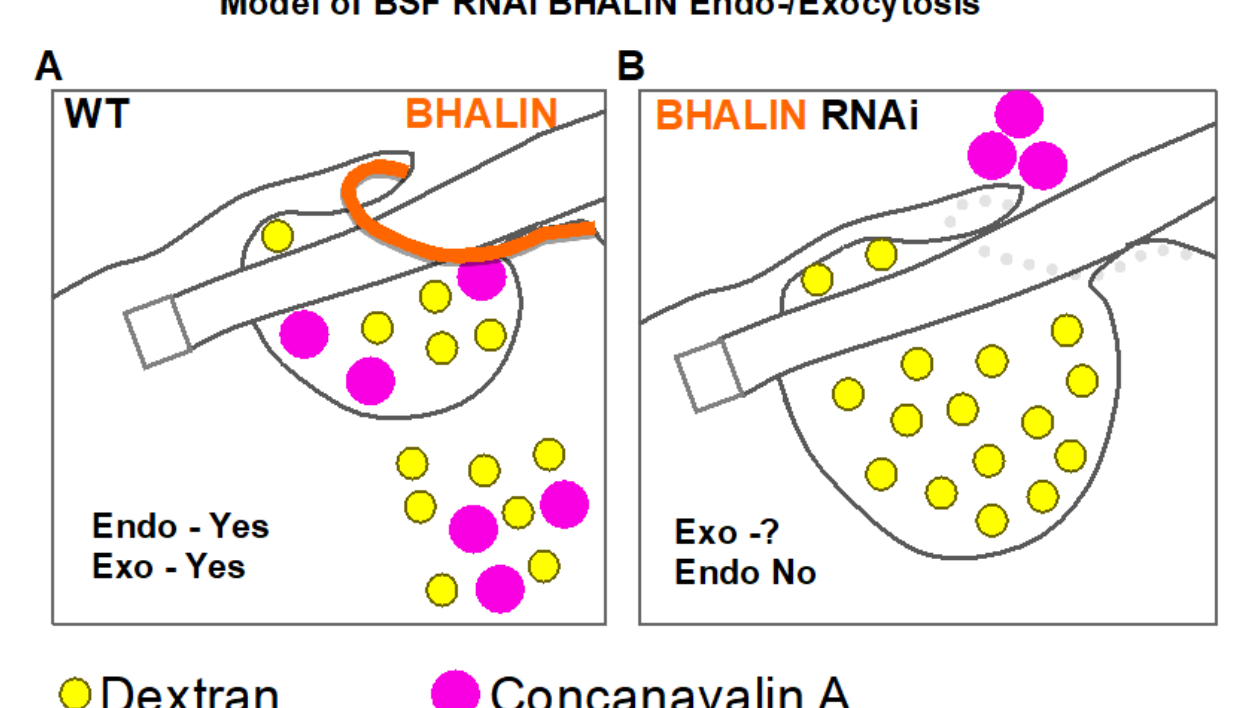
Figure 7. Scheme of BHALIN RNAi FP phenotype in BSF cell. ( A ) shows a scheme of a WT cell where endo- and exocytosis continues as normal when loaded with dextran (yellow circles) and ConA (larger purple circles). The orange line represents BHALIN. They enter the FP and then are endocytosed into the cell. In ( B ) a cell induced for 17 h with RNAi BHALIN is modelled and BHALIN protein is depleted (represented by grey circles). In this case, the FP is disrupted and enlarged and dextran (yellow circles) fills the FP whilst ConA is blocked or limited in a position near the neck of the FP (Adapted from Morriswood and Schmidt, 2015 [25]).